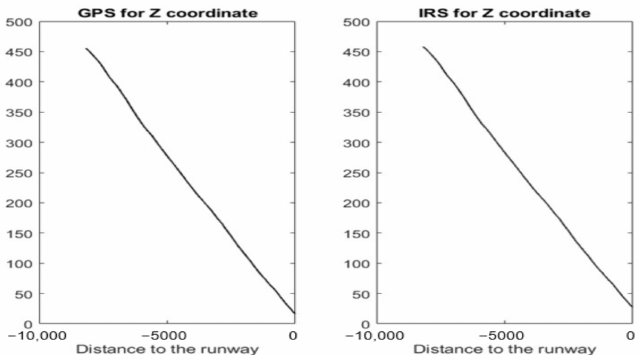
Figure 8. GPS and IRS for the Z coordinate (real values of a landing).